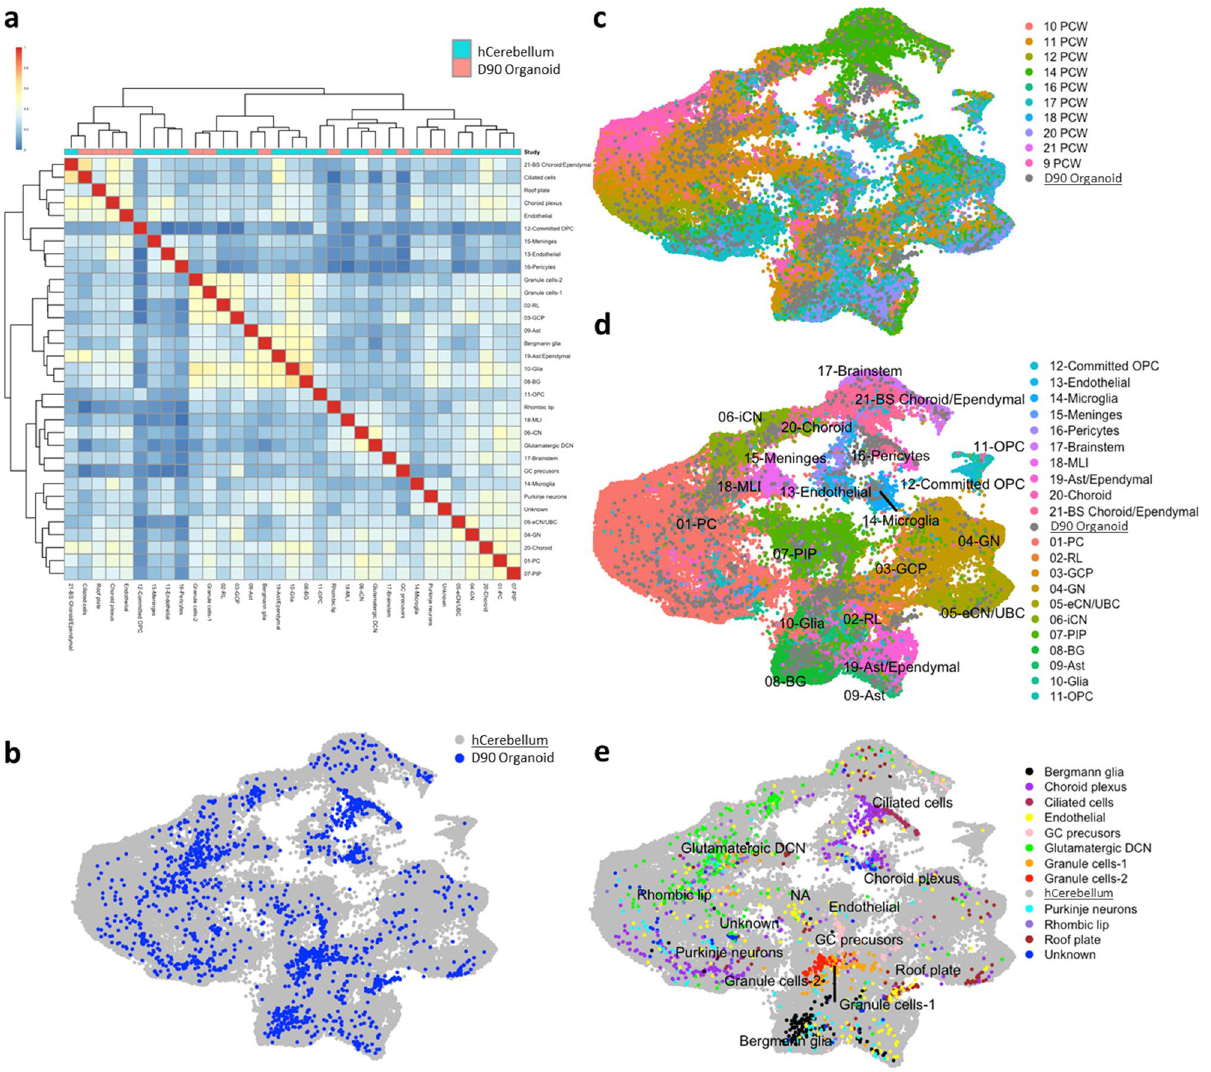
Figure 3. Human organoids comprise major cerebellar neuron types. ( a ) 69,174 human cells from ten developmental stages were integrated with 1653 human day 90 organoid-derived cells. Heatmap of Pearson correlation of average logged expression of highly-variable genes per cluster (cell type) from human cerebellar data 16 against human organoids (D90), with non-parametric/ComBat batch correction, clustering by cell type. Heatmap made with Pheatmap (v1.0.12). ( b ) UMAP plot of integrated, human organoid data (blue) with human developmental data (10-21PCW, grey) shows extensive and discrete localisation to the majority of identified human developmental clusters. ( c ) UMAP plot of integrated, human organoid data color-coded according to human developmental stage (9–21 PCW) shows complex cell-type and epoch-stage clustering. Human organoid data are represented as NA entry for visualisation purposes (grey). ( d ) Integrated object highlighting human organoid cell type identity reveals close proximity of human organoid and human developmental tissue cell types. Developmental human tissue data are coloured according to identity and human organoid data are represented as NA entry (grey) for visualisation purposes. ( e ) Integrated object highlighting human developmental tissue type identity reveals close proximity of human organoid and human developmental cell types. Human organoid data are represented as coloured while tissue data is shown as NA entry (grey) for visualisation purposes. The authors’ original cell metadata labels have been preserved for consistency. Extended clustering of pseudo-bulk cluster with time course subdivisions are shown in Supplementary Figure